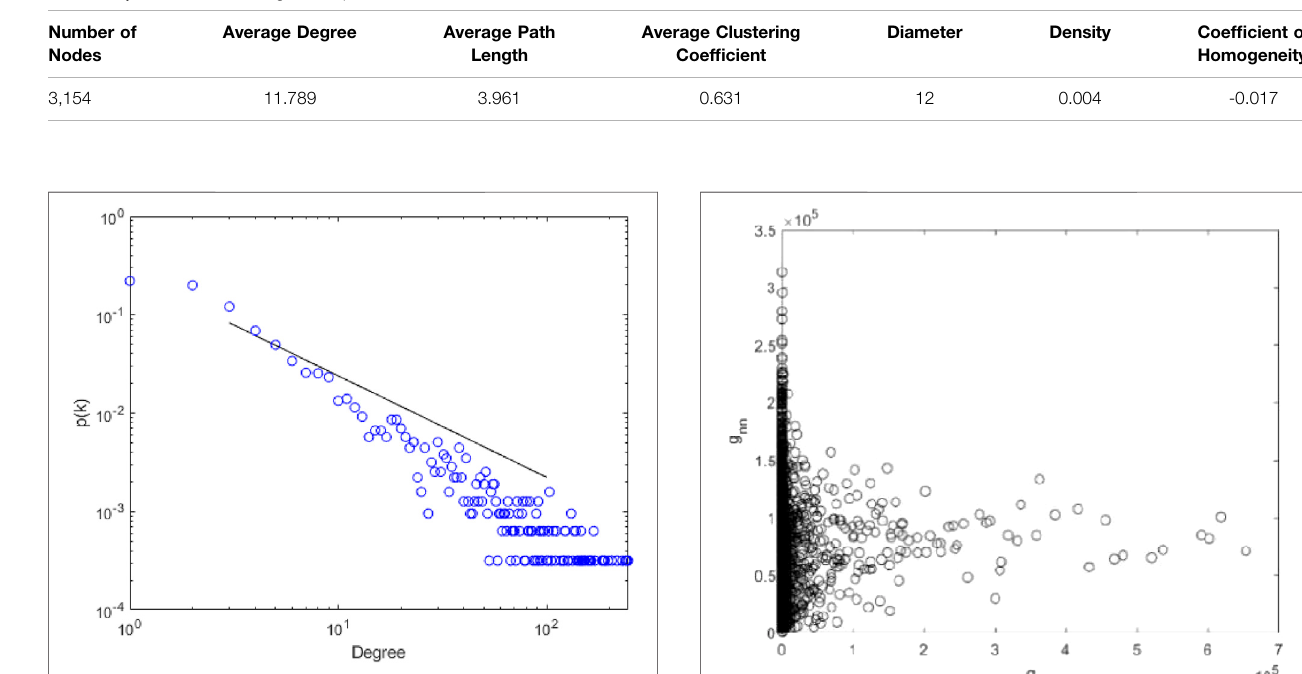
TABLE 1 | Parameters of the global airport network.